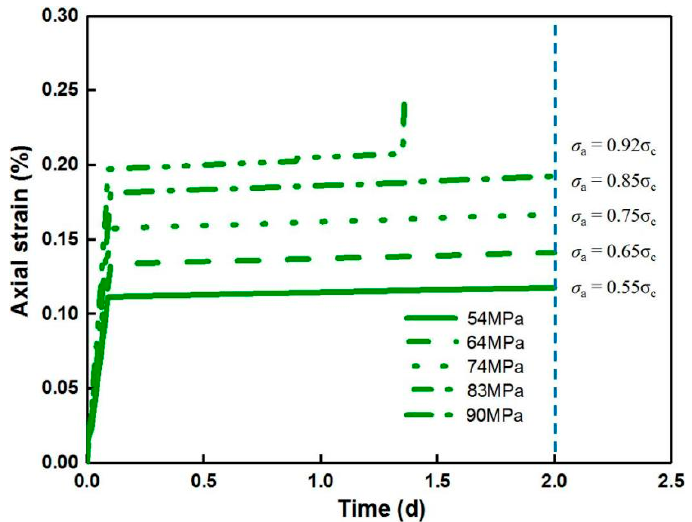
Figure 16. Behavior of creep strain with various stress levels for the constant homogeneity index ( m = 2) during uniaxial creep loading.